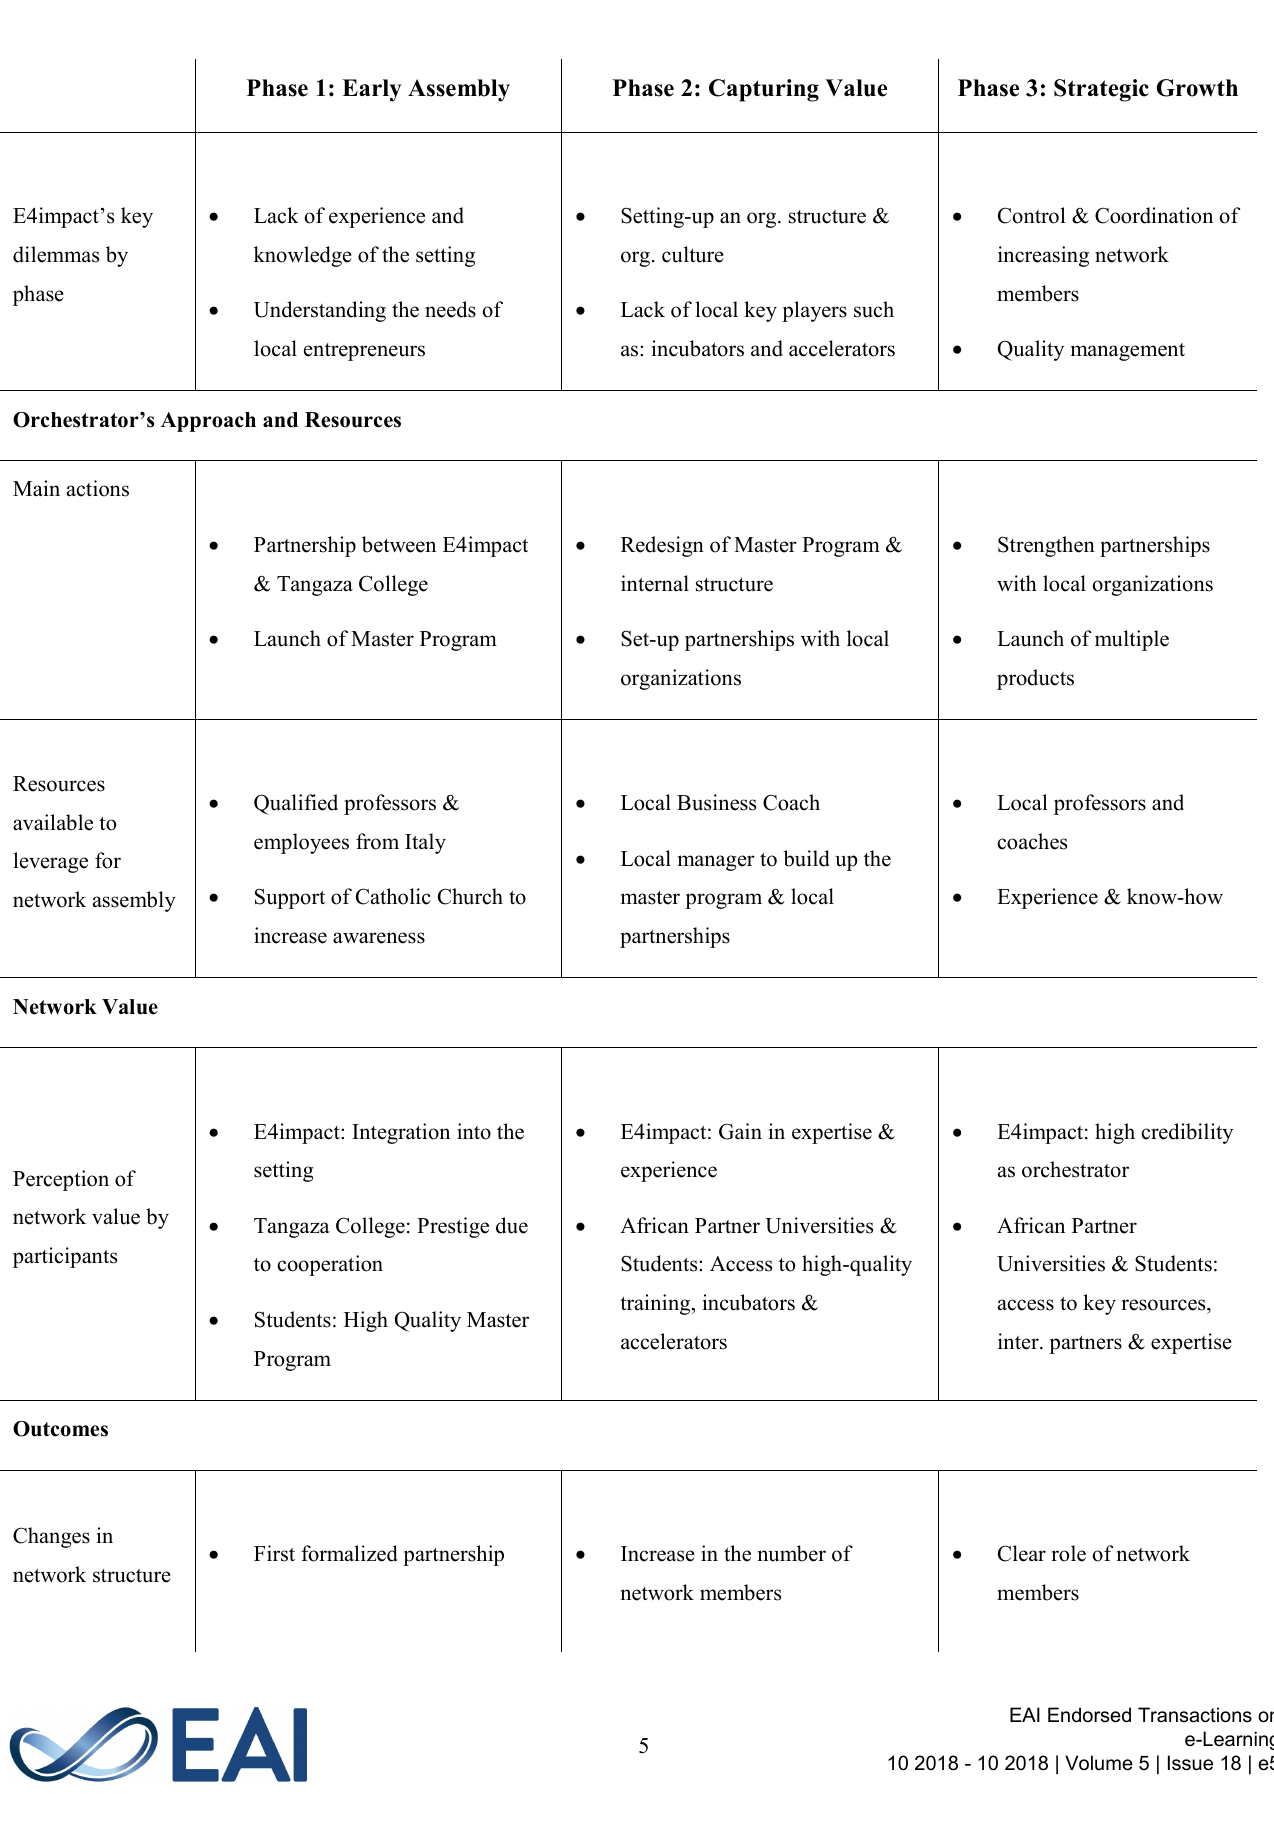
Table 1. Key Developmental Network Phase (based on Paquin & Howard-Grenville, 2013)